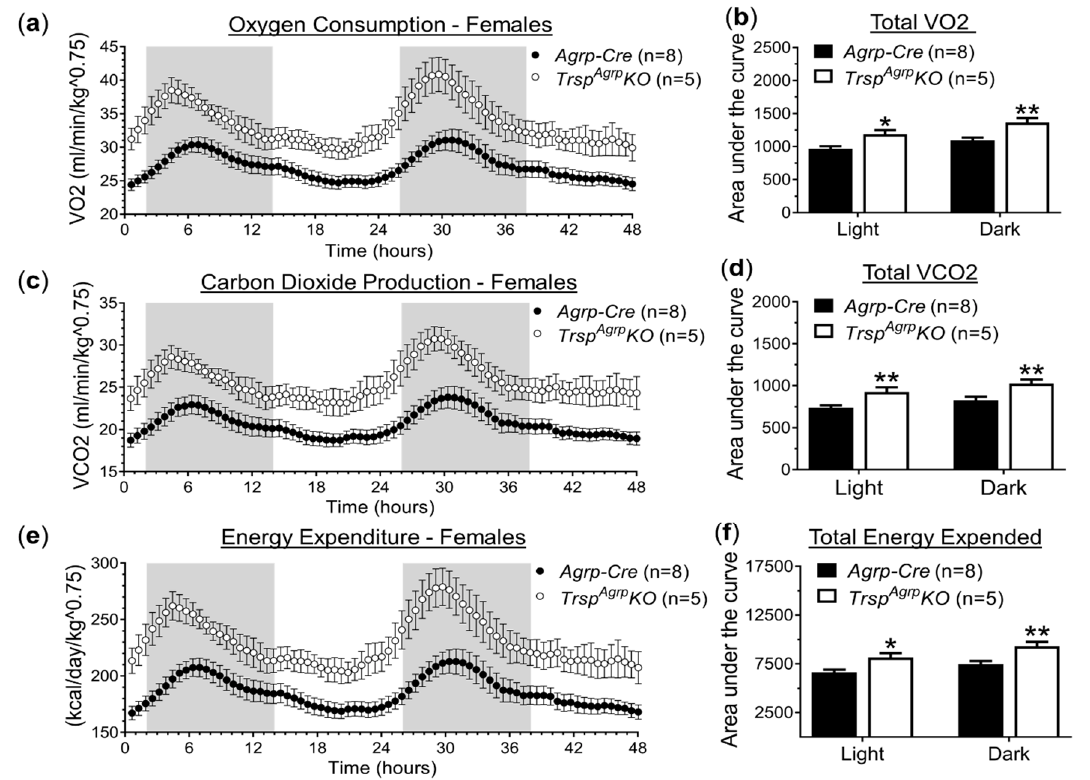
Figure 2. Respiratory metabolism of female Trsp Agrp KO mice raised on a high-fat diet. Female Trsp Agrp KO mice displayed elevated oxygen consumption (VO2, volume of oxygen) ( a , b ), carbon dioxide production (VCO2, volume of carbon dioxide) ( c , d ), and energy expenditure ( e , f ) compared to Agrp-Cre control mice. Two-way repeated-measures analysis of variance was used to compare the area under the curve during both light and dark cycles. Sidak’s multiple comparisons test: * p < 0.05, ** p < 0.01. Samples sizes are displayed in the graphs. All values shown are mean ± standard error of the mean.